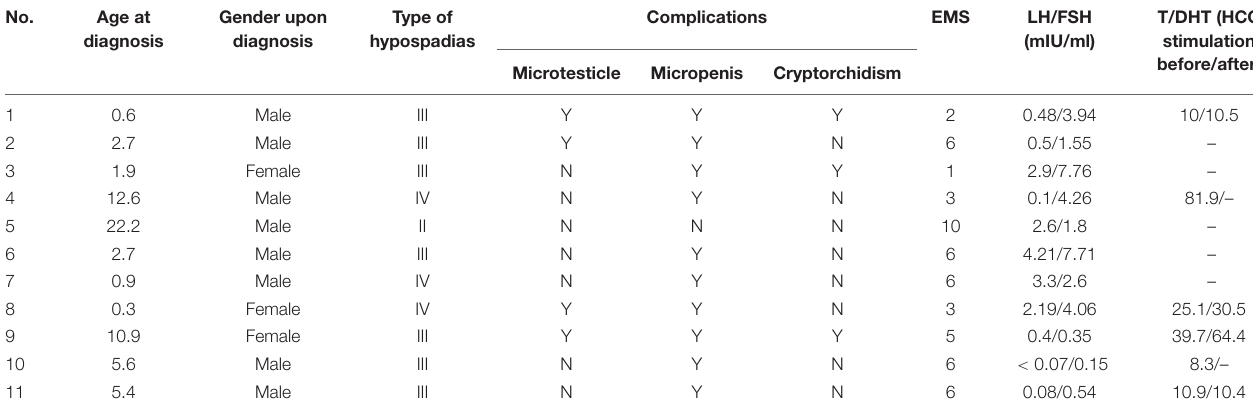
TABLE 3 | The clinical features of 11 patients carrying SRD5A2